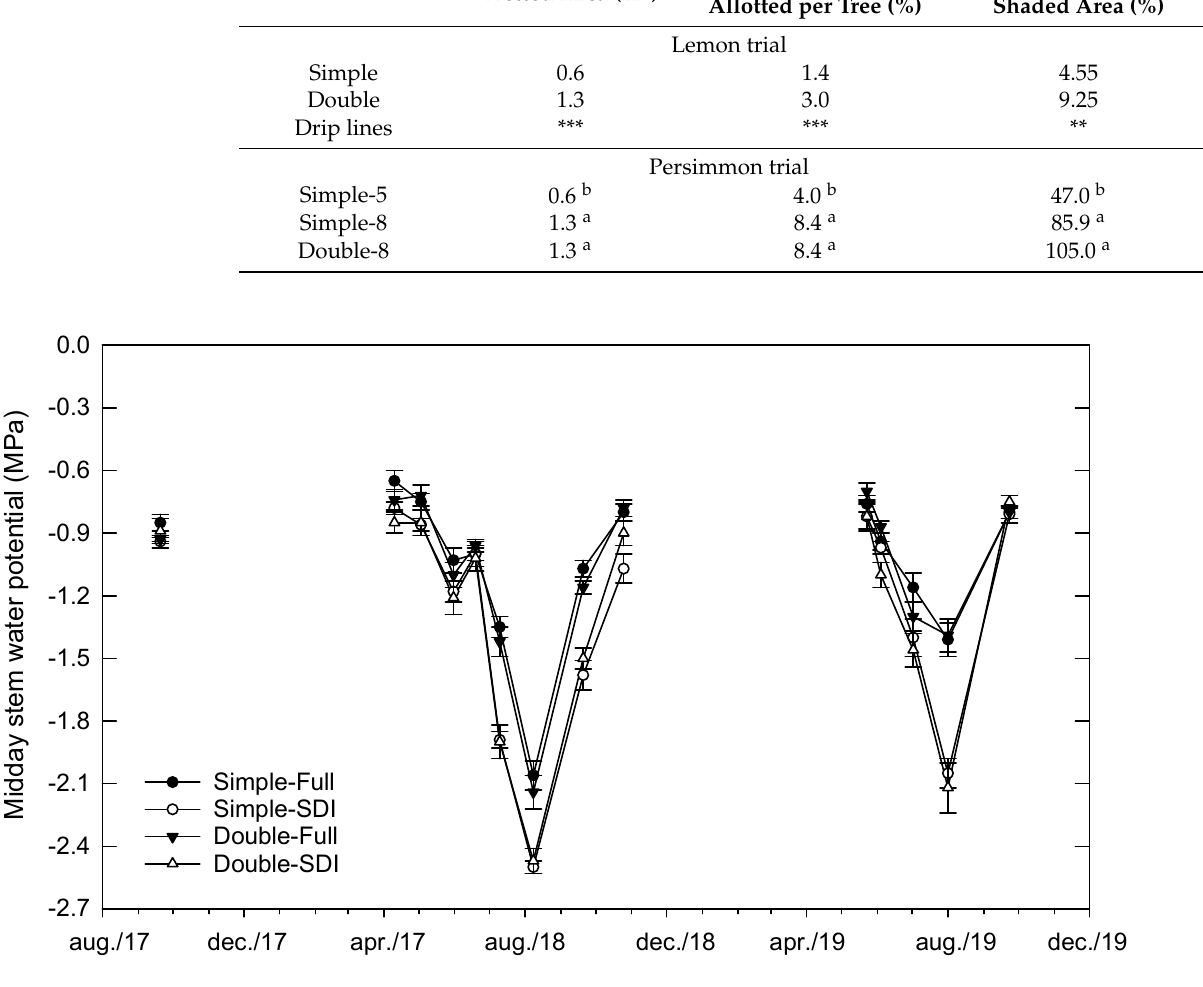
Table 4. Soil wetted area by emitters in the different experimental treatments in the lemon and persimmon trial. Data are also reported in relation to the soil allotted per tree and the tree crown shaded area. In the lemon trial, the statistical significance for the Drip lines factor included in the ANOVA is also indicated. *** and **, mean significant differences at p < 0.001 and p < 0.01, respectively. In the persimmon trial, different letters (a or b) indicate significant differences among treatments. Wetted Area by Soil Wetted Area (m 2 ) Allotted per Tree (%)